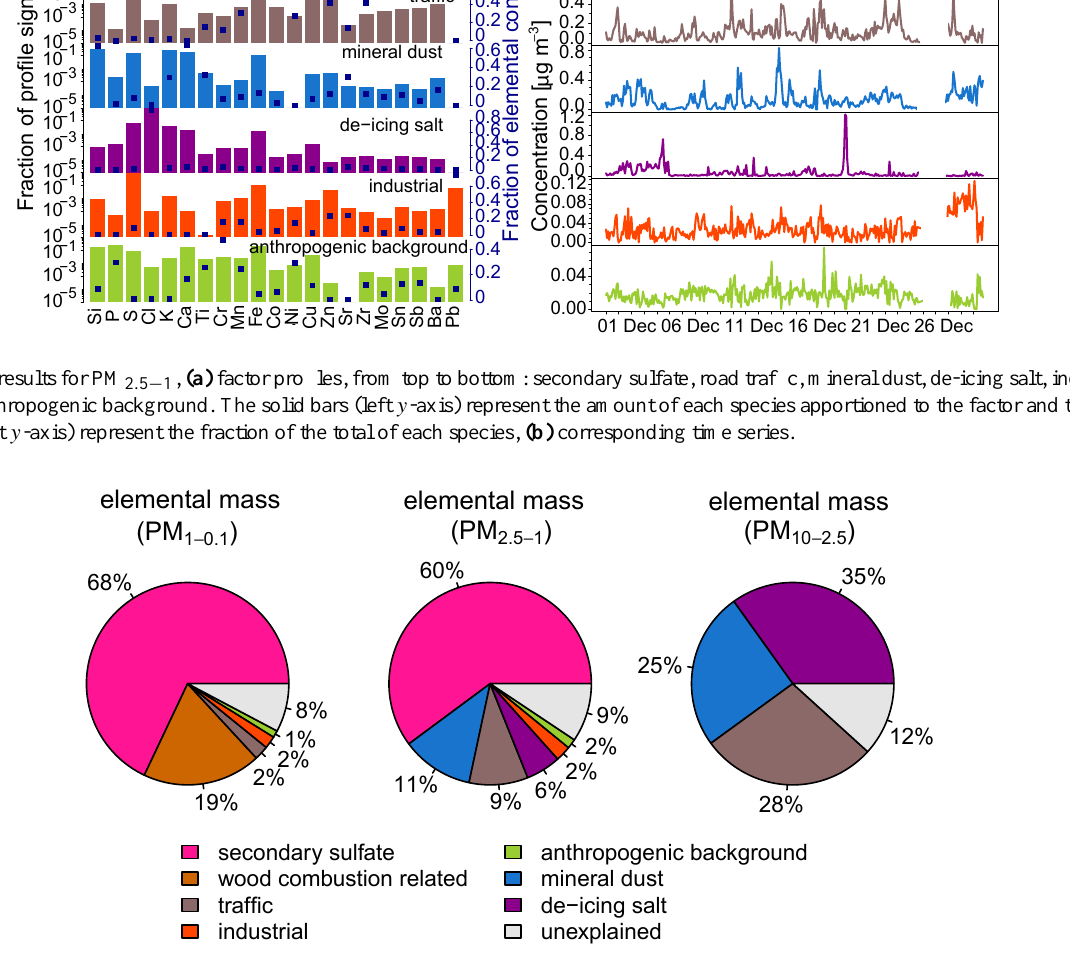
Fig. 7. Contributions of factors to the measured elemental mass concentration for all three size ranges, when exceptional data during NYE are excluded. The identified factors explain 92%, 91% and 88% of the elemental mass concentration measured in PM 1 − 0 . 1 , PM 2 . 5 − 1 and PM 10 − 2 . 5 ,